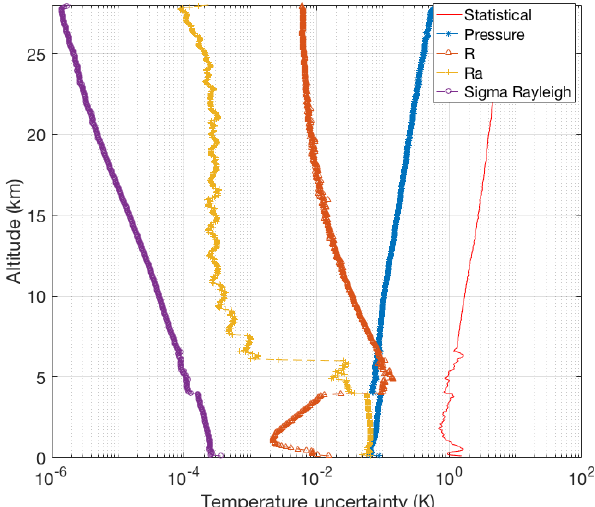
Figure 5. Random uncertainties (red curve) and systematic un- certainties due to the forward model parameters for the temper- ature retrievals from the clear nighttime RALMO measurements on 9 September 2011. The systematic uncertainties included are Rayleigh-scatter cross section (purple dot-dashed curve), R photon- counting coupling constant (dashed orange curve with triangles), R a analog coupling constant (dashed yellow curve with crosses), and pressure (dashed blue curve with dots).